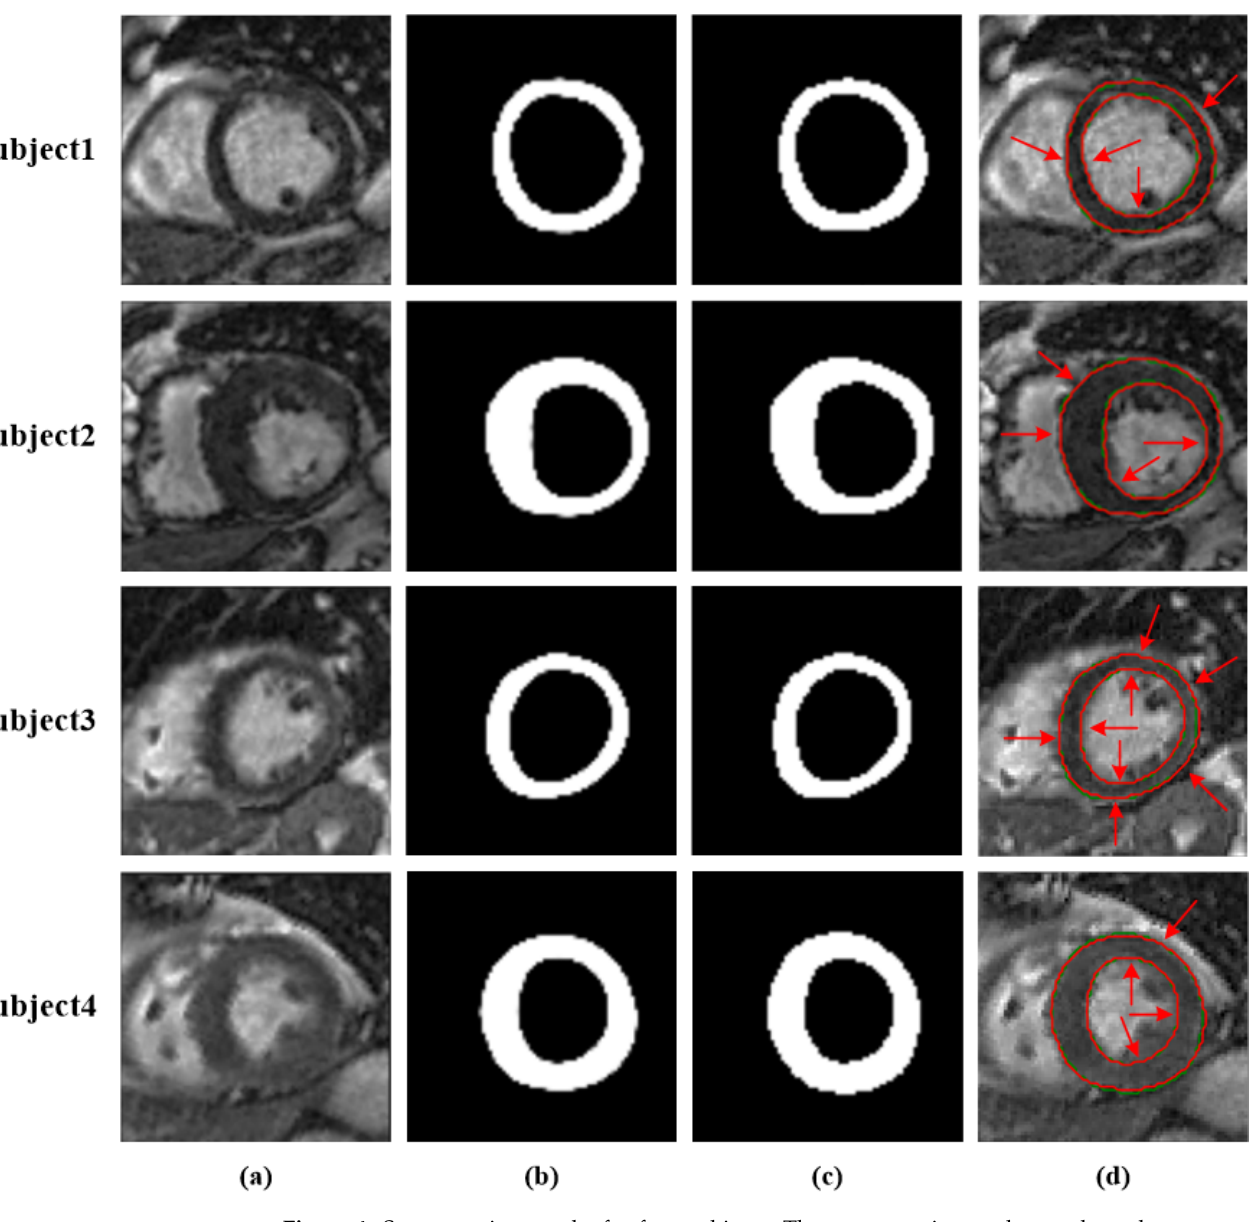
Figure 4. Segmentation results for four subjects. The arrows point to places where the proposed method can be seen to almost overlap with the GT manually delineated by the experts, indicating better segmentation. ( a ) Cardiac MR image. ( b ) Results of segmentation using the suggested method. ( c ) GT. ( d ) The segmentation contours obtained by the proposed method are marked by red curves, and the corresponding GT manually delineated by experts is marked by green